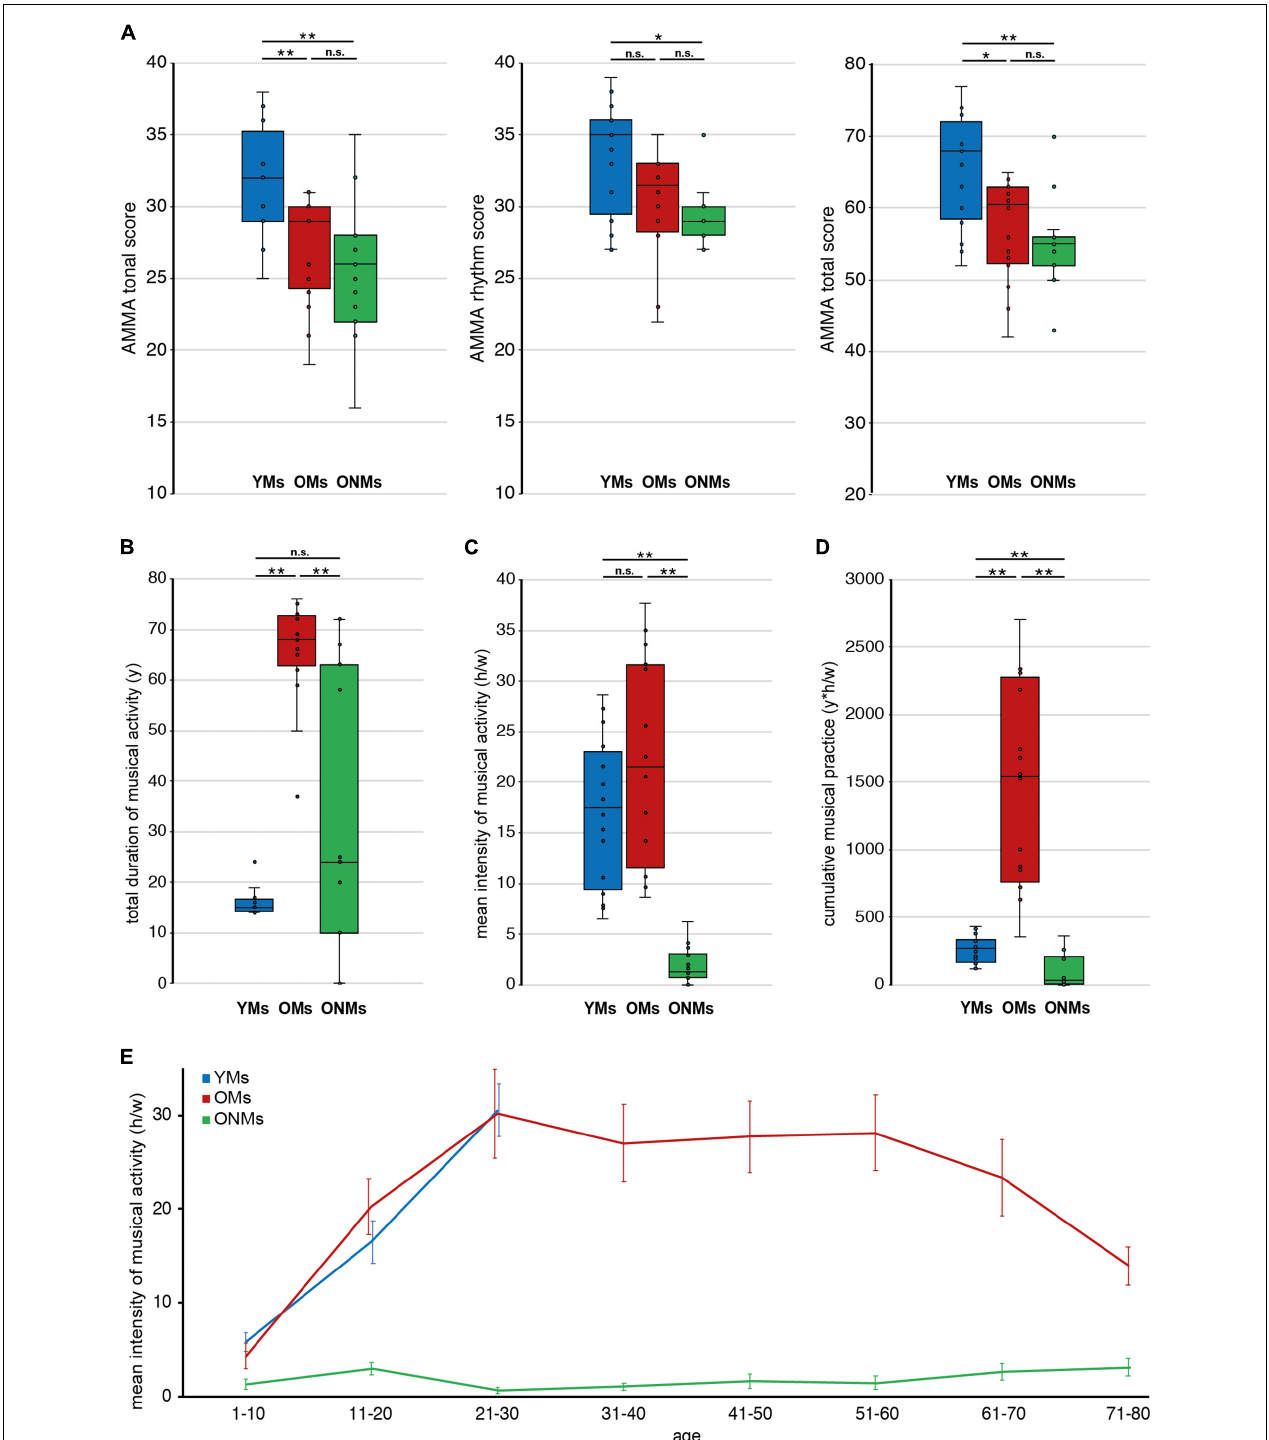
FIGURE 1 | Musicianship-dependent scores. Average musicianship scores of young musicians (YMs), old musicians (OMs), and old non-musicians (ONMs): (A) tonal, rhythm, and total scores of the AMMA test; (B) total duration of musical activity (y) across the lifespan; (C) mean intensity of musical activity (h/w) presented for the lifespan; (D) cumulative musical practice (y*h/w) across the lifespan; (E) mean intensity of musical activity (h/w) presented for each decade separately, and error-bars represent SEM. (A–D) Whiskers in the boxplots represent data range. For more details, see corresponding Table 1 . YMs, young musicians; OMs, old musicians; ONMs, old non-musicians; AMMA, Advanced Measures of Music Audiation test; y, years; h/w, hours/week; y*h/w, years*hours/week. **Significance level p < 0.001; *significance level p < 0.01; n.s., not significant.